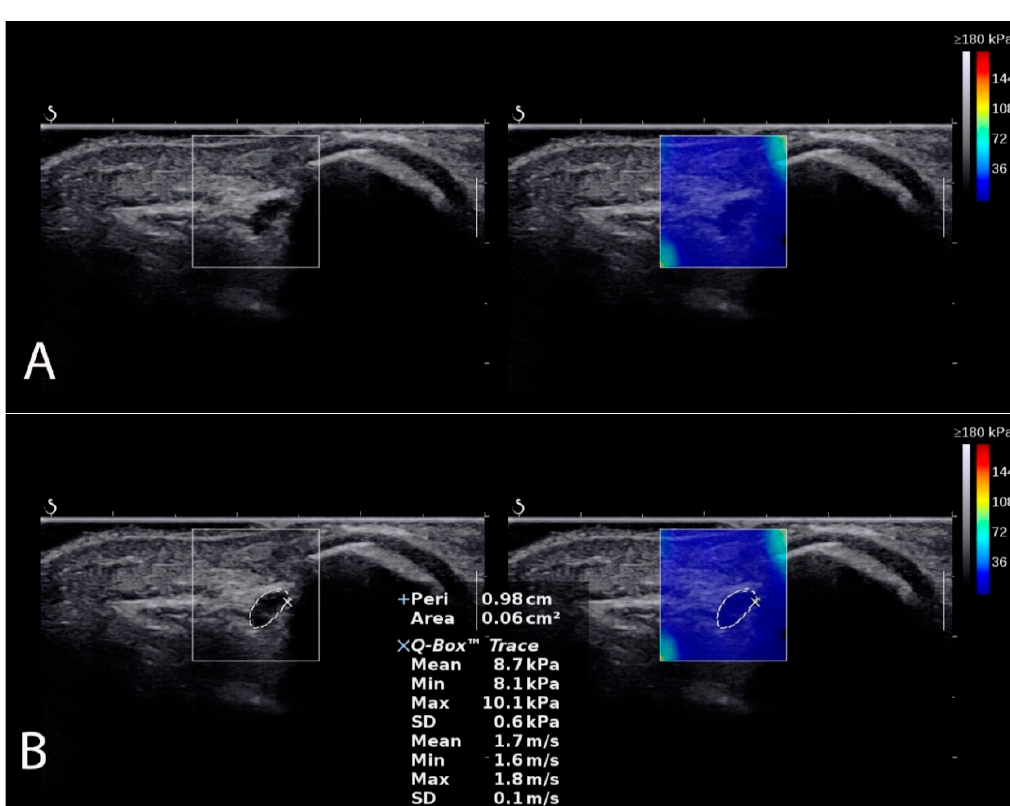
Figure 2. Ulnar nerve localization in SWE mode ( A ). Measurement example ( B ) of CSA, shear modulus, and TRACE.